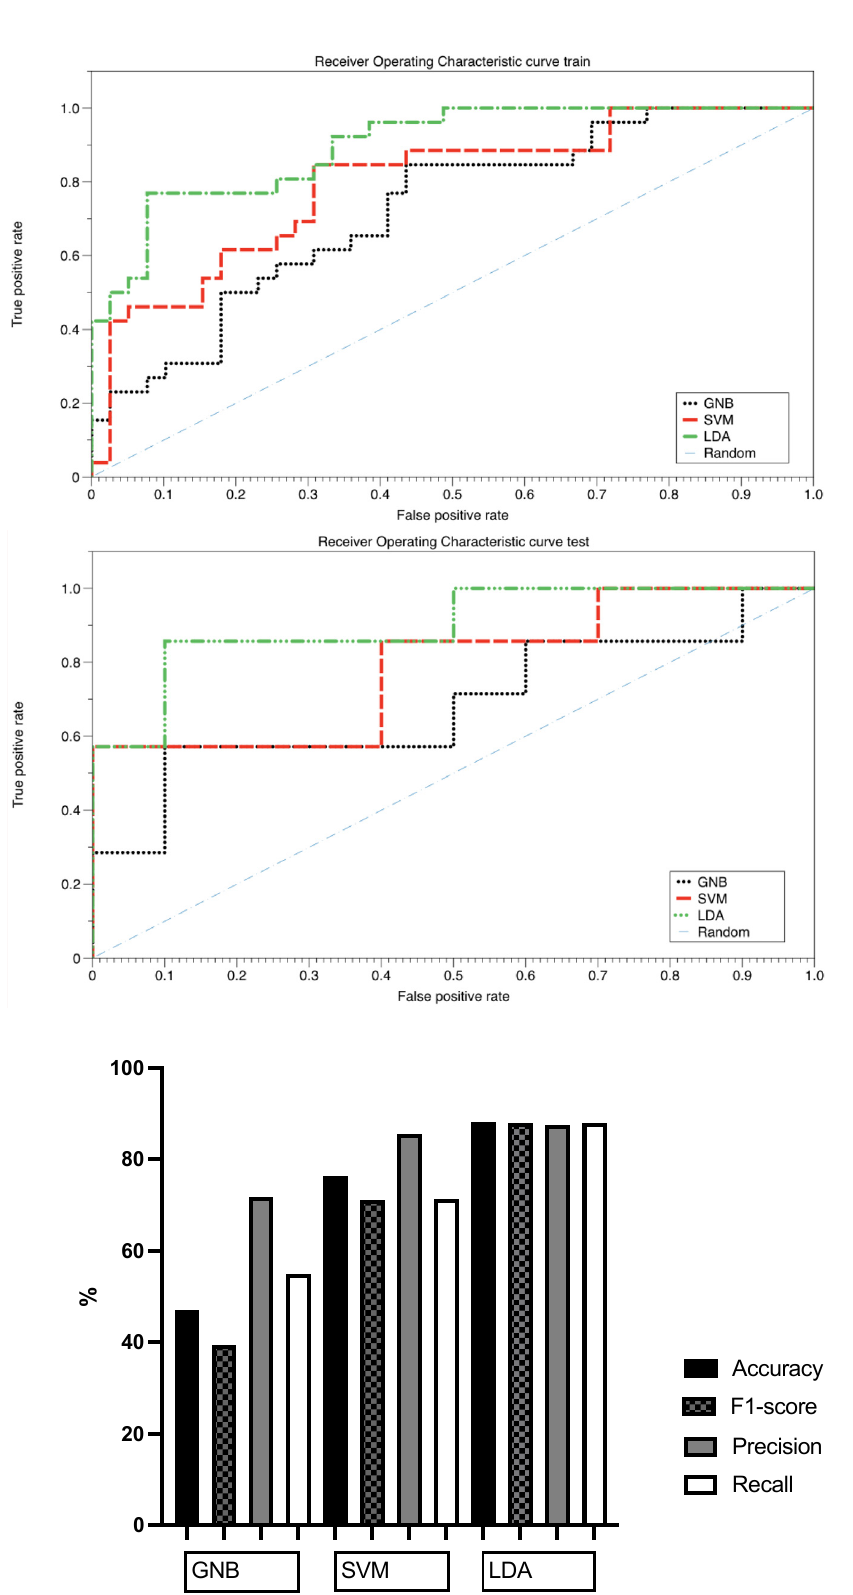
Figure 6. Receiver Operation Characteristic Curve (ROC) for each model and histogram of the obtained metrics.